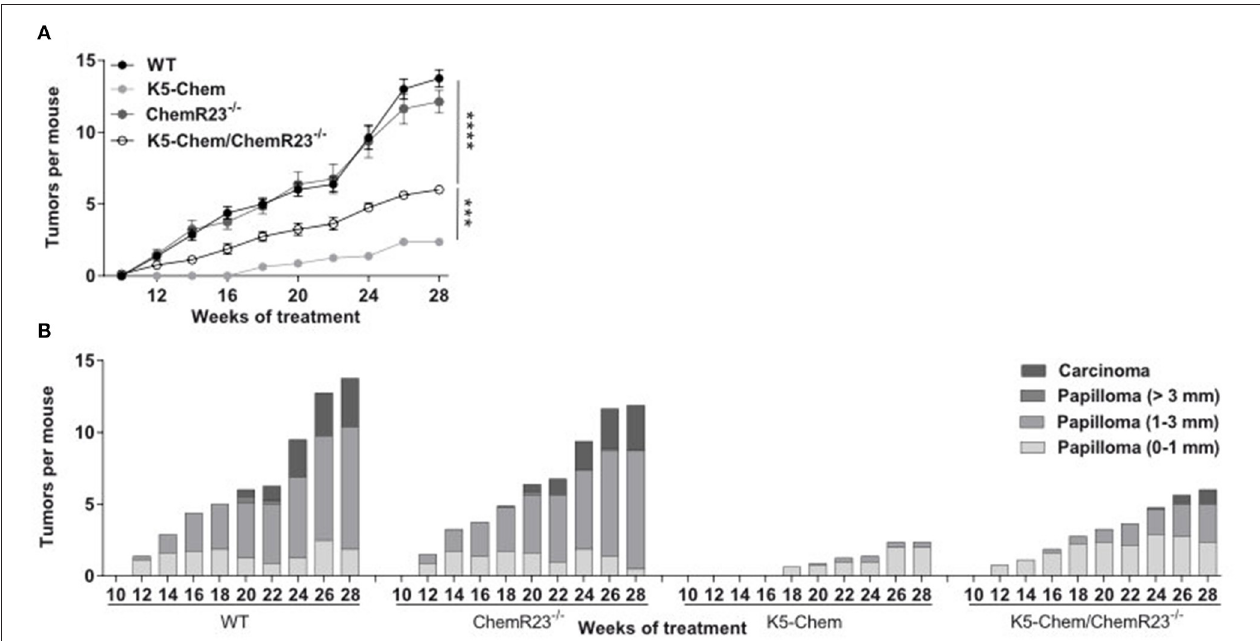
FIGURE 8 | The anti-tumoral properties of chemerin are mediated in part by ChemR23. Control, K5-chemerin, ChemR23 − / − and K5-chemerin/ChemR23 − / − mice were subjected to the DMBA/TPA chemical carcinogenesis model and the number of tumors per mouse ( A , mean ± SEM) and size/stage (B) were recorded. The data are the compilation of three independent experiments with n ≥ 5 mice per group in each experiment. The data are analyzed by two-way ANOVA. *** P < 0.001 and **** P <